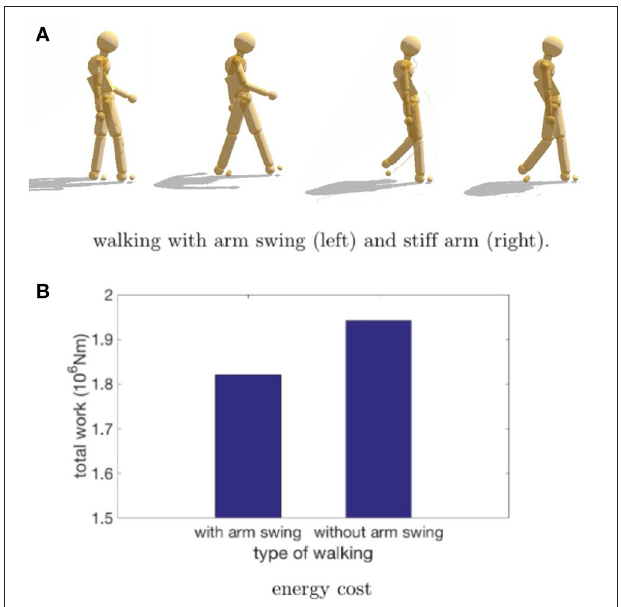
FIGURE 10 | Comparison of efforts while walking with/without arm swing. (A) In a preliminary test of our design, the energetic cost of normal walking is compared to the case where the arms are constrained from swinging. Our hypothesis is that if subjects are instructed to walk without moving their arms, they will accomplish this by using muscle co-contraction and that this effect can be realized in the HDM with stationary markers that keep the arms vertical. (B) The increased cost measured by the HDM is 6.1%, extremely close to the 6% result obtained by Ortega et al. (2008).